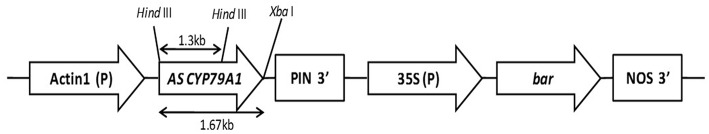
Partial map of CYP79A1 Antisense RNA construct (pJS108-CYP79A1-AS) Vector backbone from plasmid pJS108 (courtesy: Dr. Ray Wu, Cornell University, USA); Act1- Promoter of rice actin (Act 1) gene; A.S CYP79A1- cDNA of CYP79A1 in antisense orientation; 35S—CaMV35S promoter; bar encodes the enzyme Phosphinothricin acetyl transferase that confers Basta resistance; PIN and NOS—termination sequences.